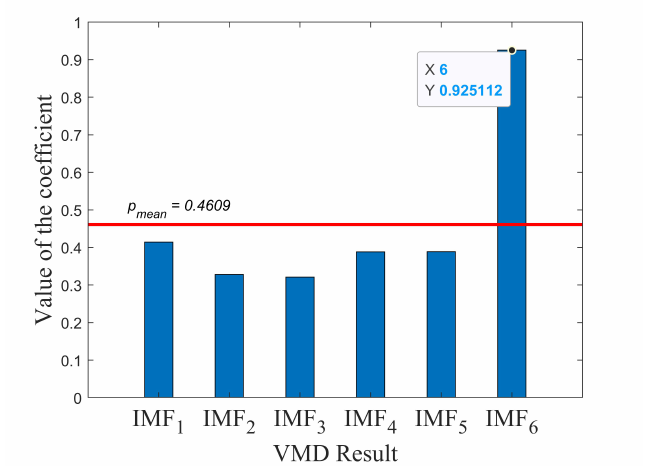
Figure 6. Evaluation results of IMF